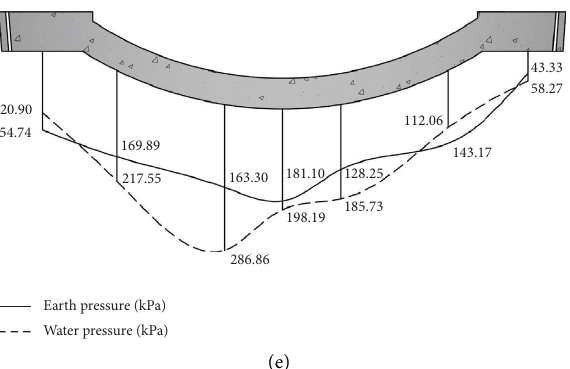
Figure 9: Relationship between the earth and water pressure of the basement rock: (a) before operation; (b) one month; (c) six months; (d) one year; (e) two years.